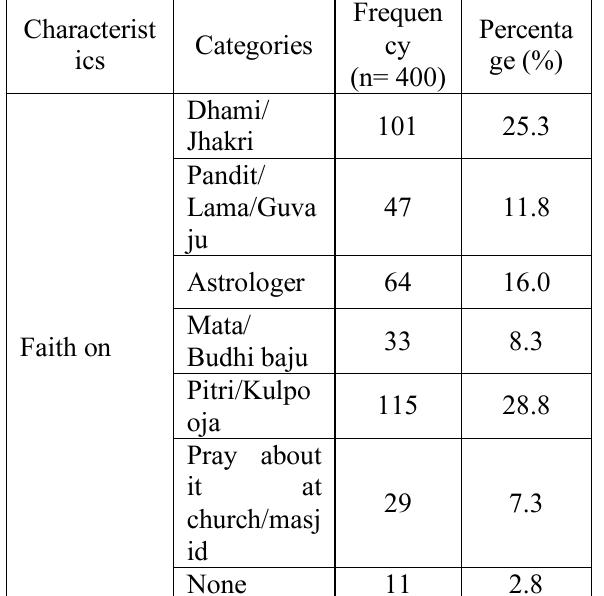
Table 2: Types of first approach of seeking health for the reported illness and faith of the respondents on traditional healer